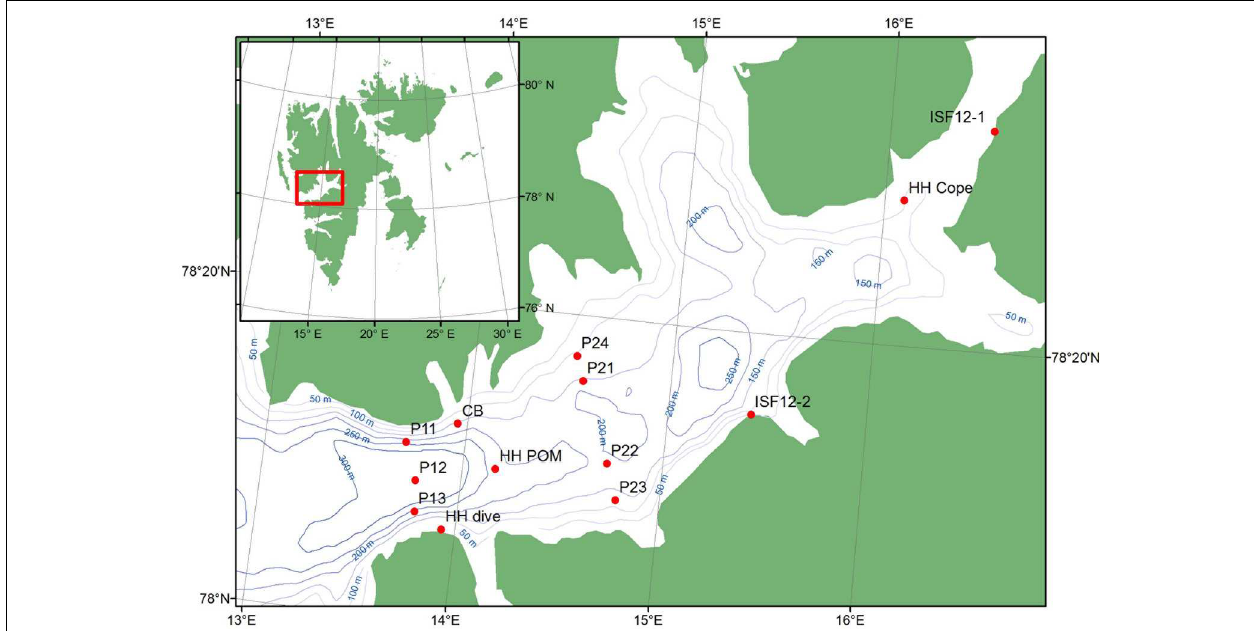
FIGURE 1 | Map of the study area of Isfjorden, Svalbard indicating sampling stations.